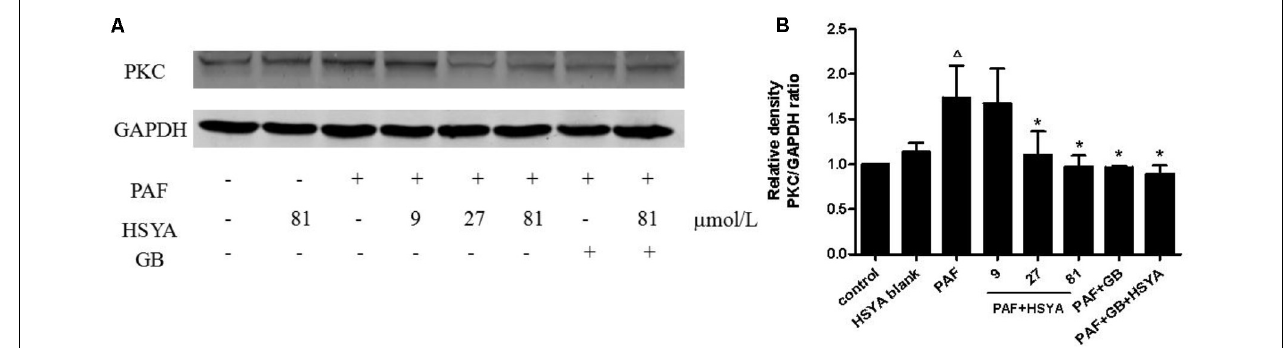
FIGURE 7 | Effect of HSYA on protein expression level of PKC in PAF-stimulated HSAECs analyzed by western blotting (A) . Densitometric analyses of PKC (B) . Data presented as mean ± SD, n = 3 per group. ANOVA, p < 0.05, post hoc (cid:49) p < 0.05 versus control group, ∗ p < 0.05 versus PAF group. GAPDH was used as an internal